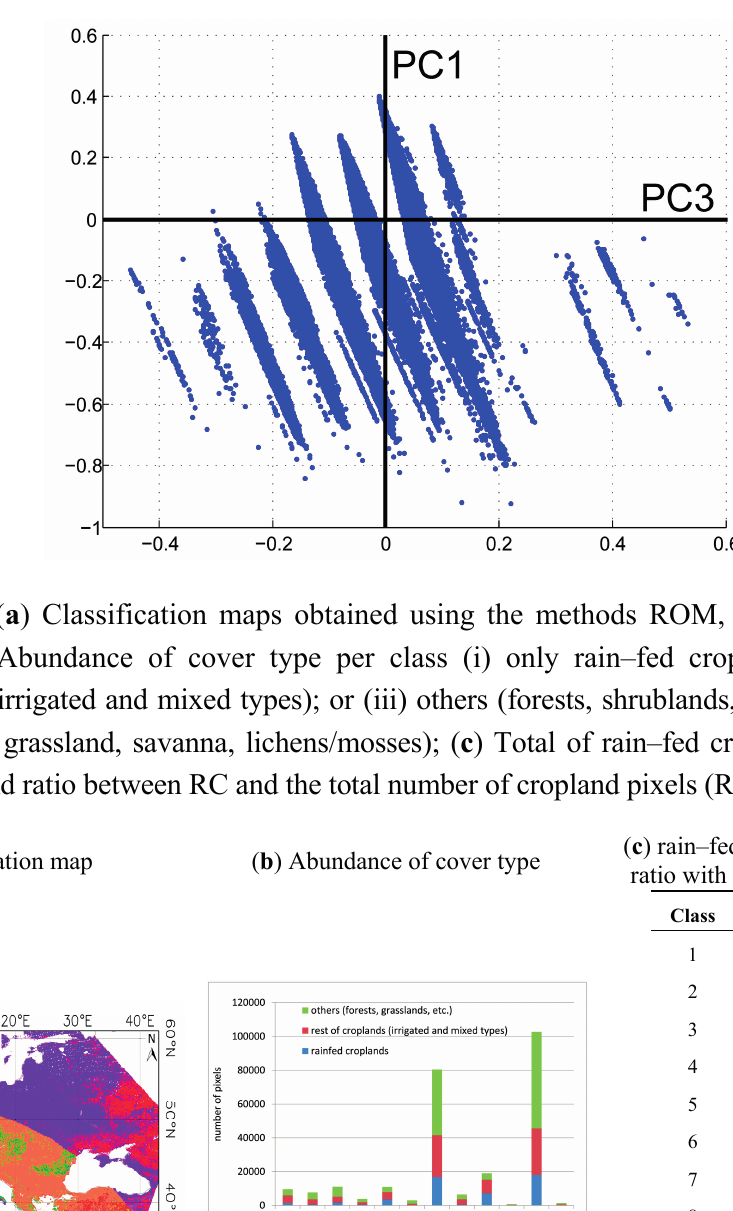
Figure 3. Scatter plot of first principal component (PC1) versus the third (PC3) obtained in Europe from the classification dataset proposed in this paper.